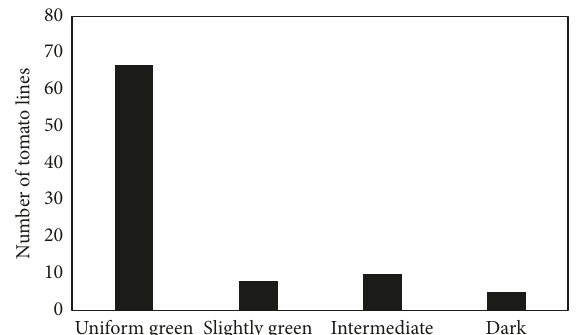
Figure 8: Distribution of ninety-one fresh-market tomato geno- types based on green shoulder.